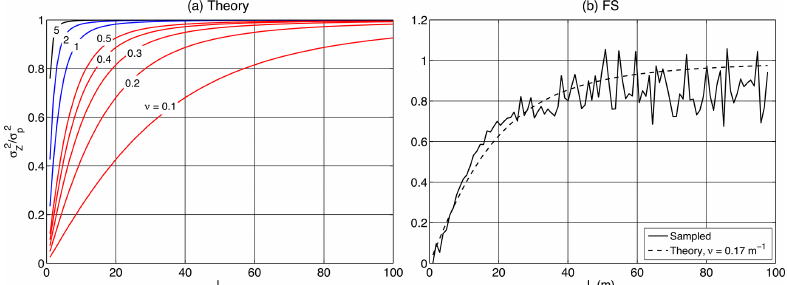
. σ 2 p ) for the two-dimensional case with a single measurement in the middle of a Figure 13. (a) Theoretical normalized squared error ( σ 2 Z square area with side dimension L . (b) Theoretical and sampled normalized squared error for the same two-dimensional survey applied to the snow depth field in FS. The dashed line is the theoretical error derived for an exponential decay exponent of 0.17 derived from the sampled correlation function of snow depth in FS, while the solid line is the sampled normalized squared error for the snow cover in FS.